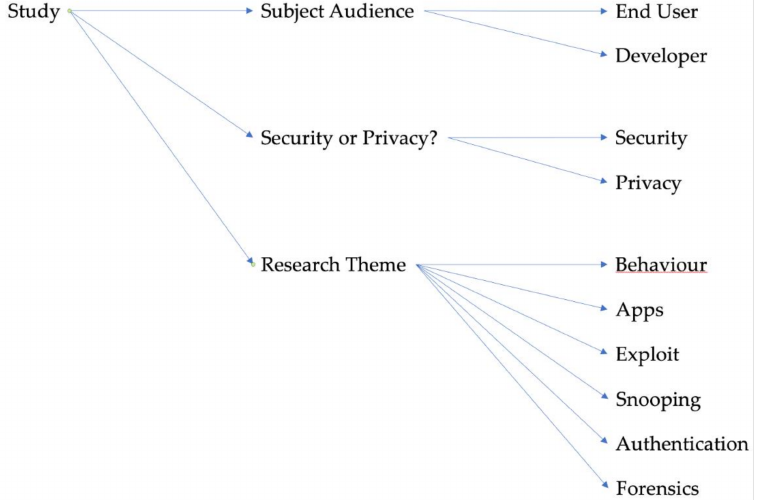
Figure 5. A taxonomy tree showing categories used to classify different reviewed